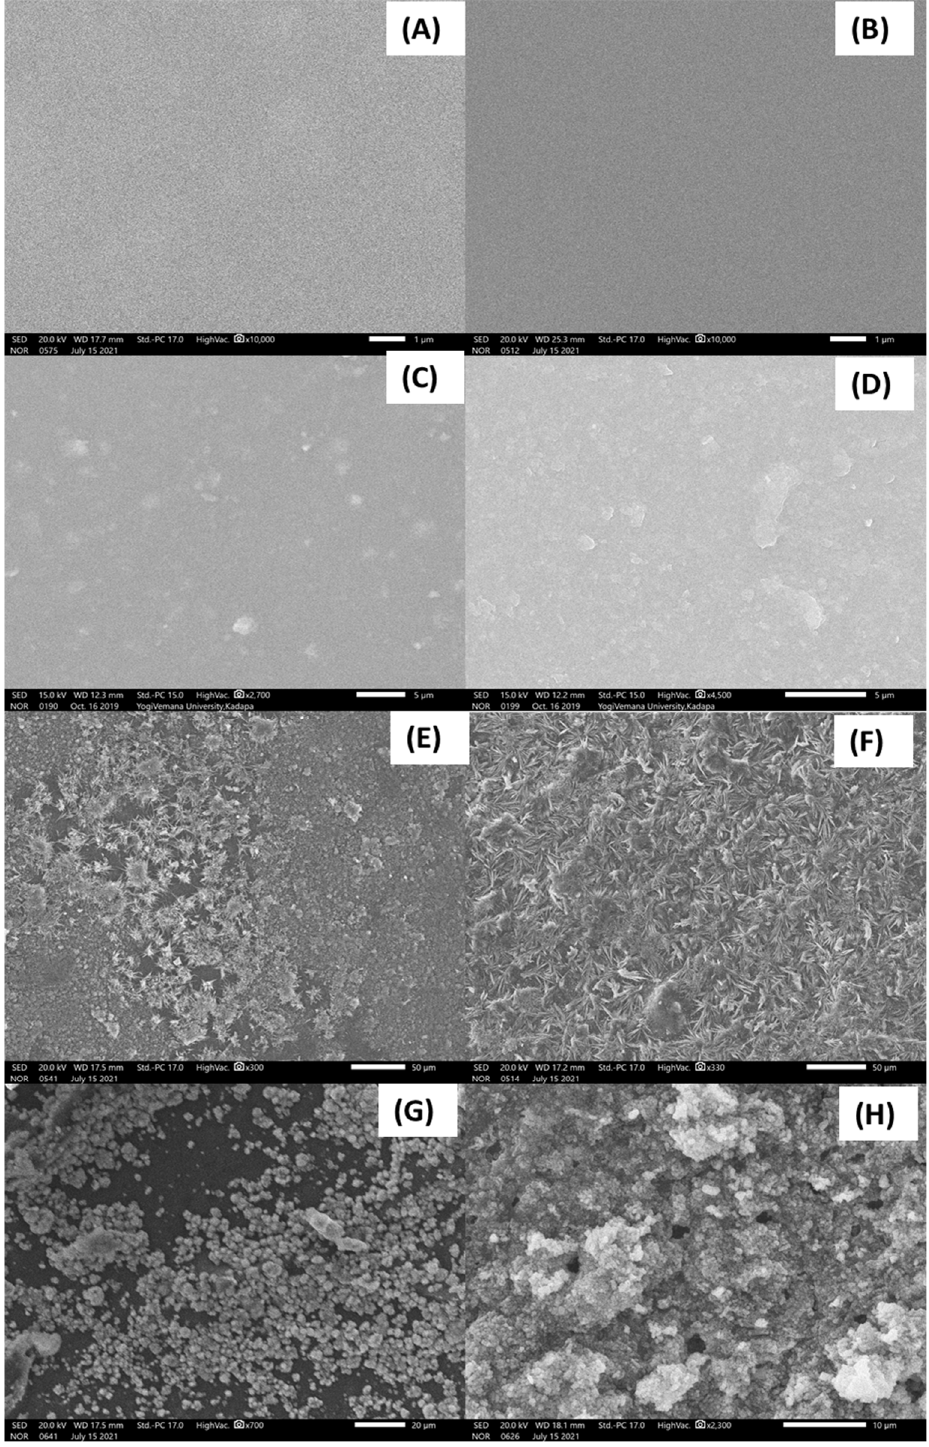
Figure 3. SEM images of PSAAM ( A ), PSASB ( B ), PSAAM-PMA ( C ), PSASB-PMA ( D ), PSAAM-5FU